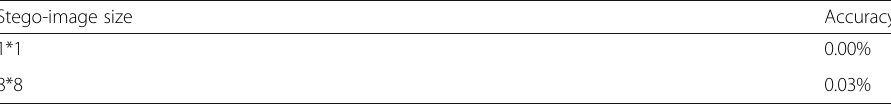
Table 4 Steganalysis results Stego-image